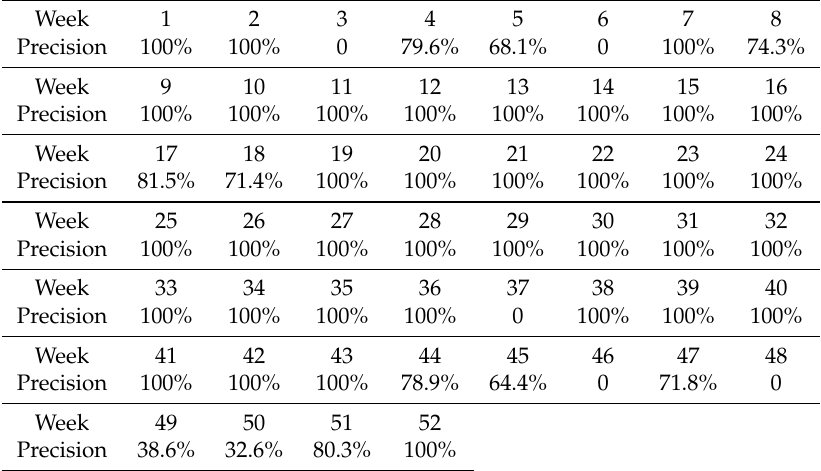
Table A3. The precision of anomaly detection results for weekly data of School